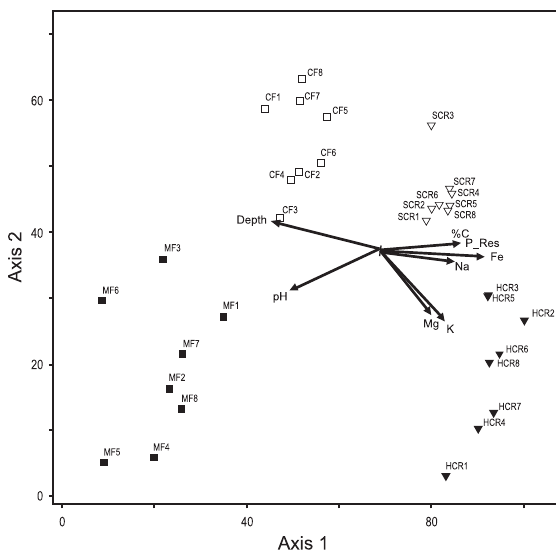
Figure 4. Canonical correspondence analysis (CCA) ordination of environmental variables and species abundance for the four vegetation types at Serra Sul, Serra dos Carajás, state of Pará, Brazil: herbaceous campo rupestre, shrubby campo rupestre, capão forest, and montane